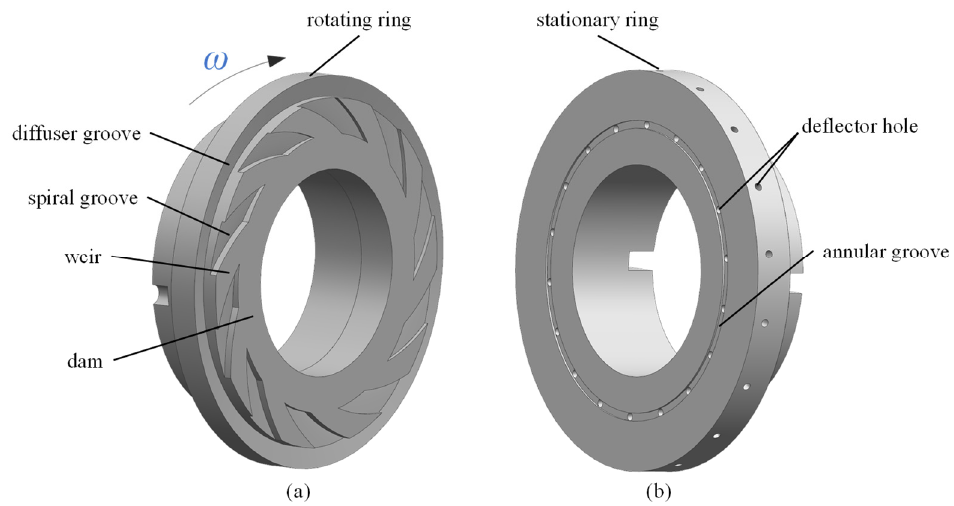
Figure 1. Structure of the rotating and stationary rings of the diffuser groove self-pumping hydro- dynamic mechanical seal: ( a ) The rotating ring; ( b ) The stationary ring. The arrow on the image indicates the direction of rotation of the rotating ring.